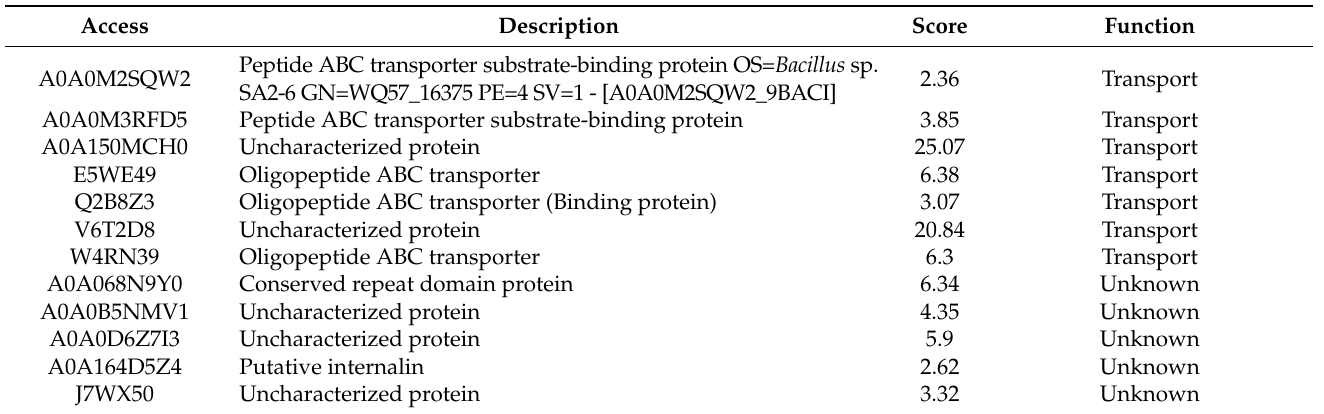
Figure 3. The dehydrogenase activity in the control soils and those treated with the different products at concentrations of 0.1% w / w ( A ) and 0.5% w / w ( B ). Points (mean ± SD) with the same